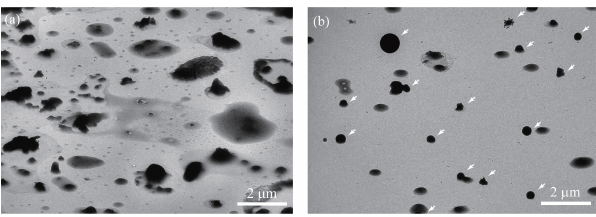
Figure 5. Representative TEM images of (a) adhering and (b) re- bounding PM at 95% RH collected between 14:15 and 18:15UTC on 30 September 2014 during IOP2. The rebound fraction dur- ing the time period of collection approached 0.3. The arrows in panel (b) highlight the locations of particles having high vertical dimensions and spherical or dome-like morphologies, as expected for solid